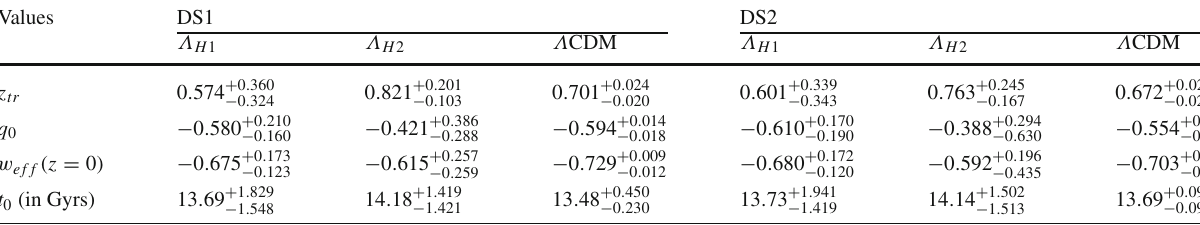
Table 2 The numerical values of a tr , z tr , q 0 , w ef f ( z = 0 ) and t 0 using best-fit results of model